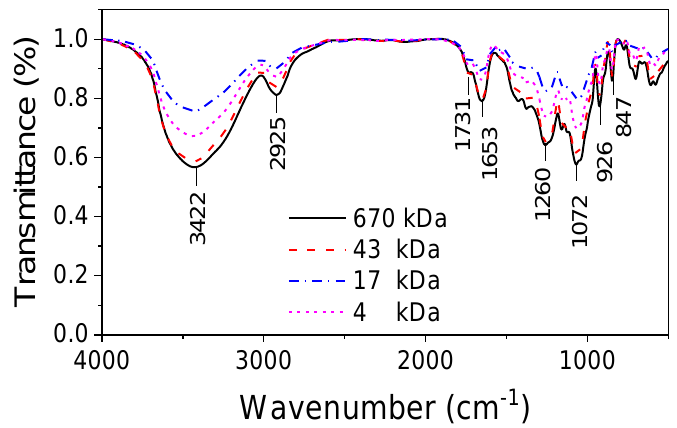
Figure 2. FTIR spectra of oligocarrageenans with different molecular weights.